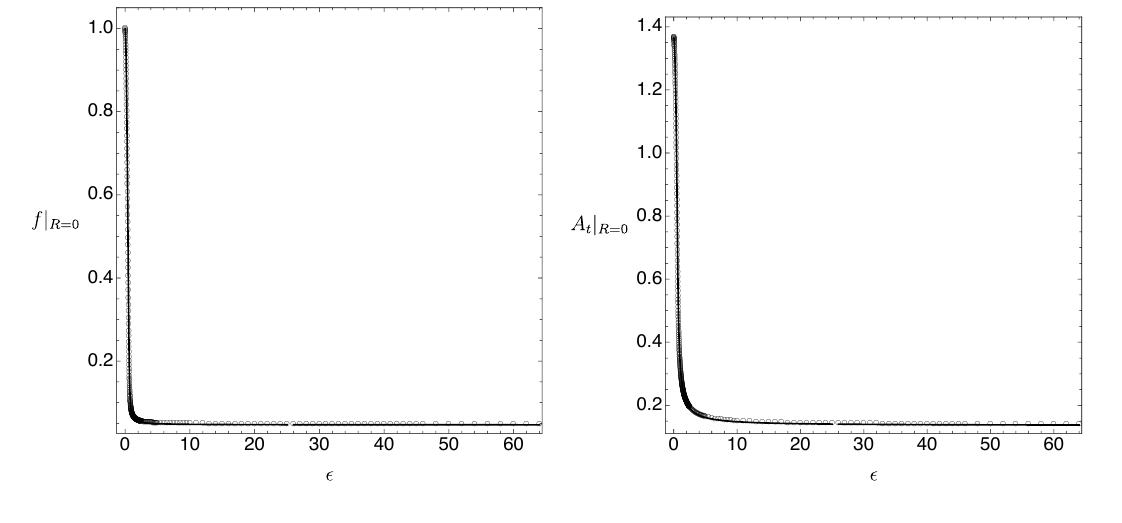
Figure 13 . Main soliton family with e = 2 . 3 ( e > e